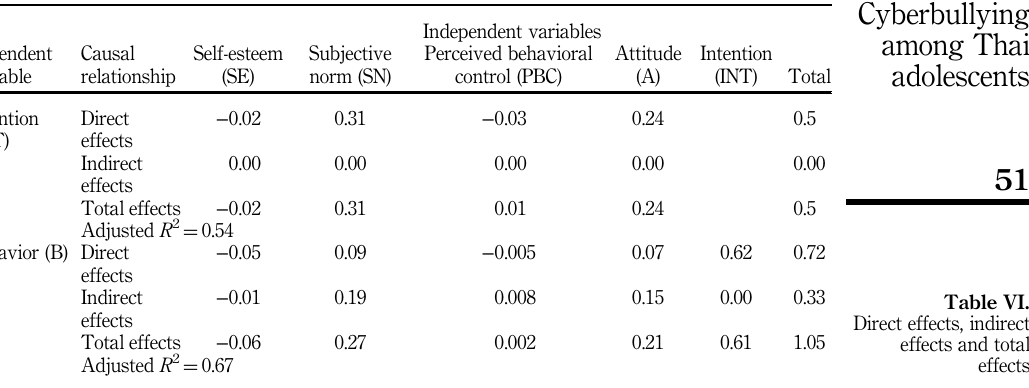
Table VI. Direct effects,